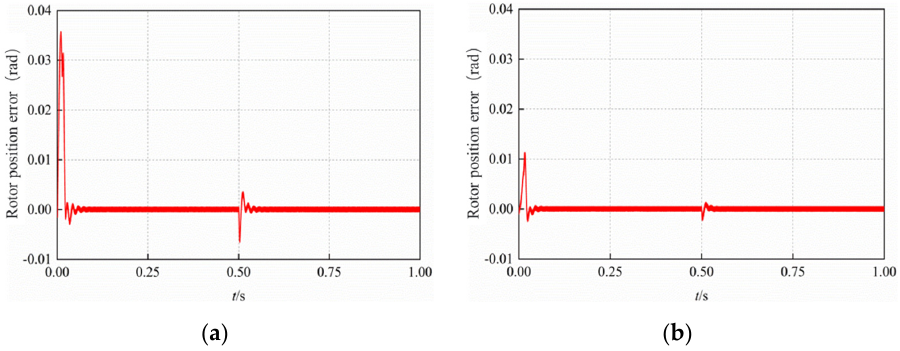
Figure 17. Simulation waveform of rotor position error under sudden change of load torque. ( a ) Traditional MRAS algorithm. ( b ) STSM − MRAS algorithm.